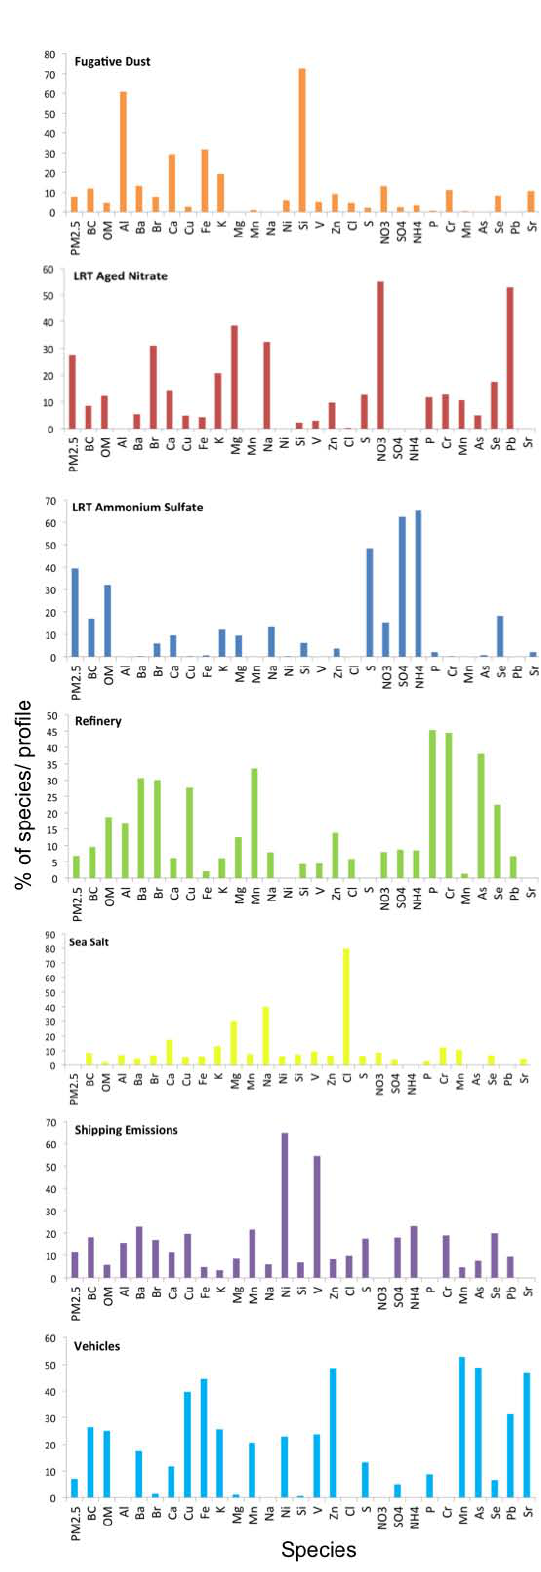
Fig. 8. Source profiles for the seven PMF